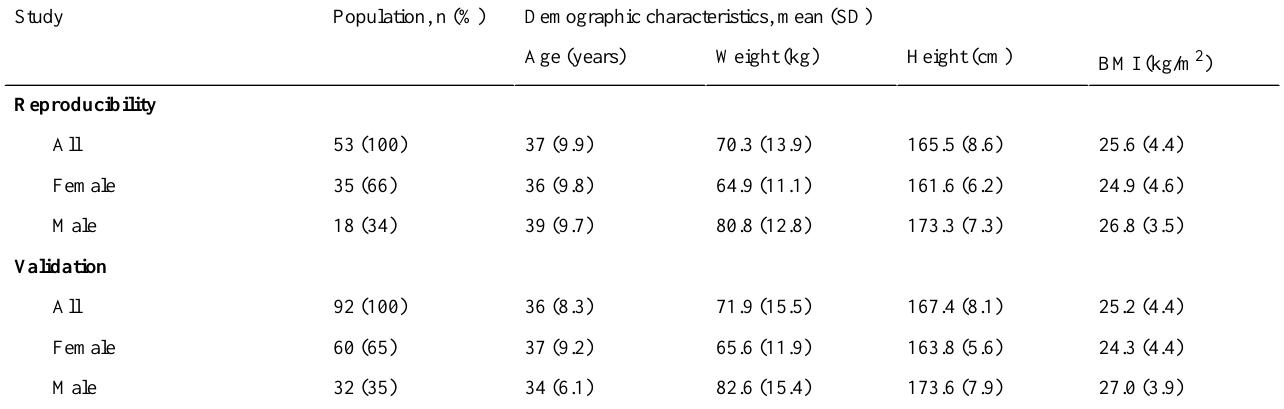
Table 1. Demographic characteristics of participants who completed the reproducibility and validation